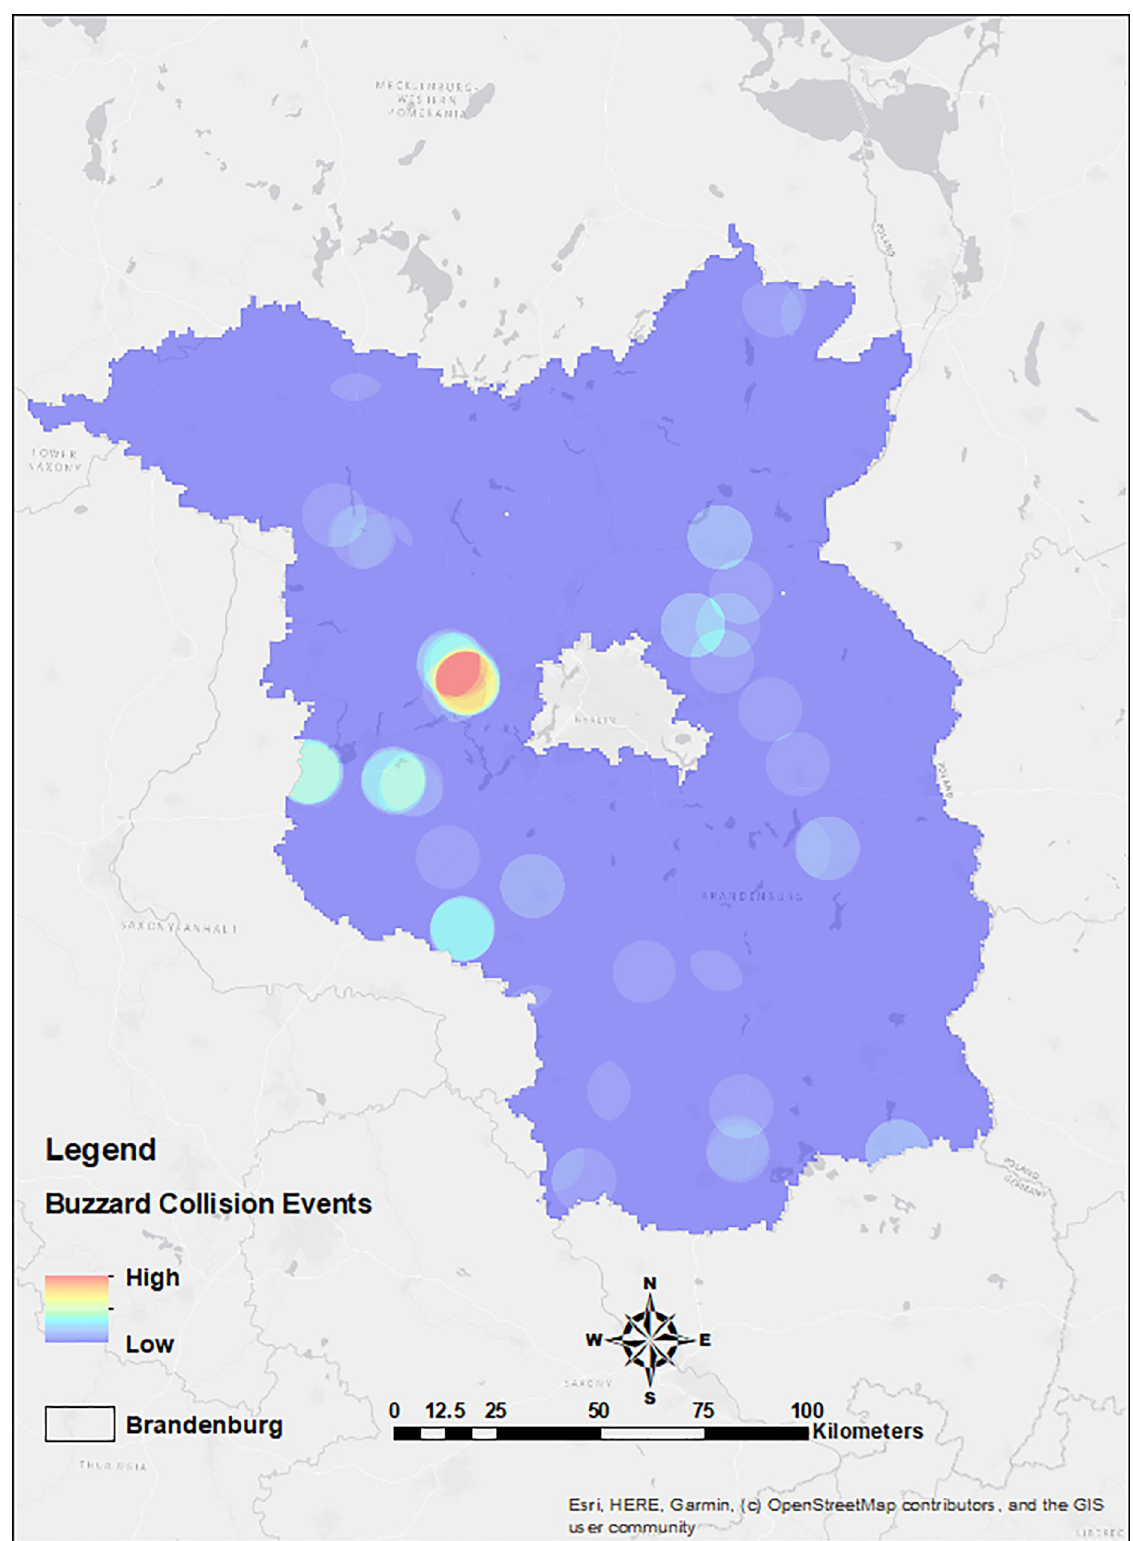
Fig 10. Buzzard collision events density in the study region of Brandenburg, Germany.